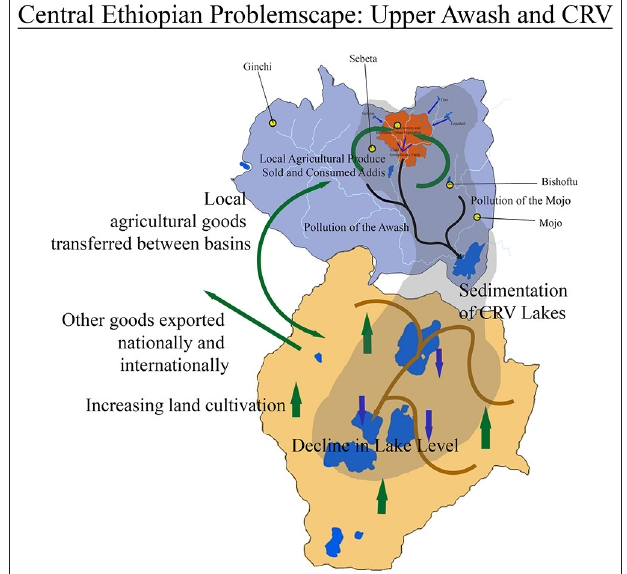
FIGURE 5 | Upper Awash and CRV